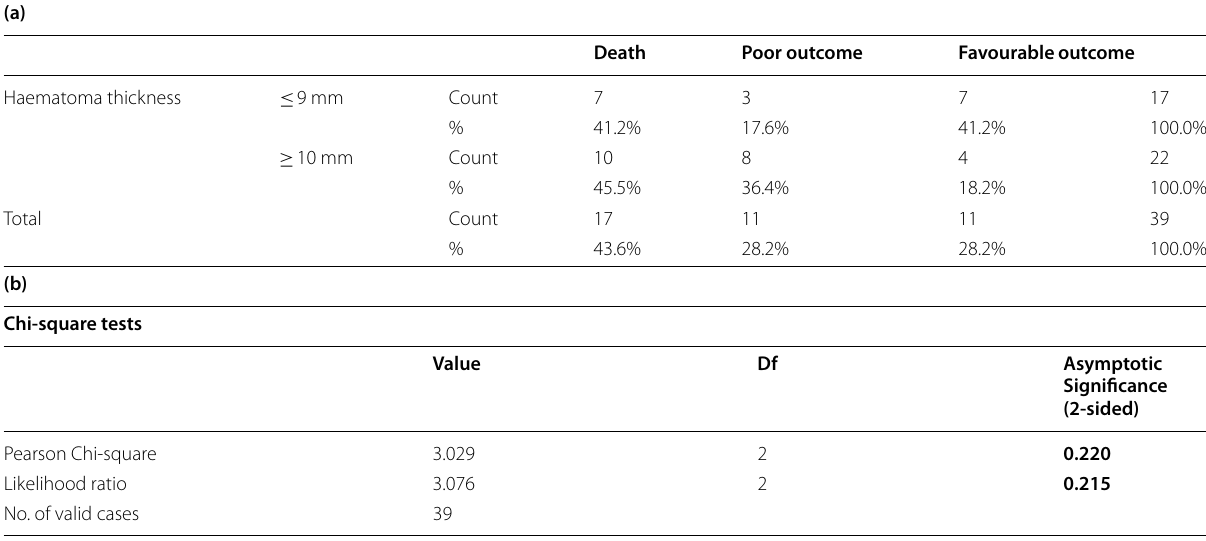
Df. degrees of freedom